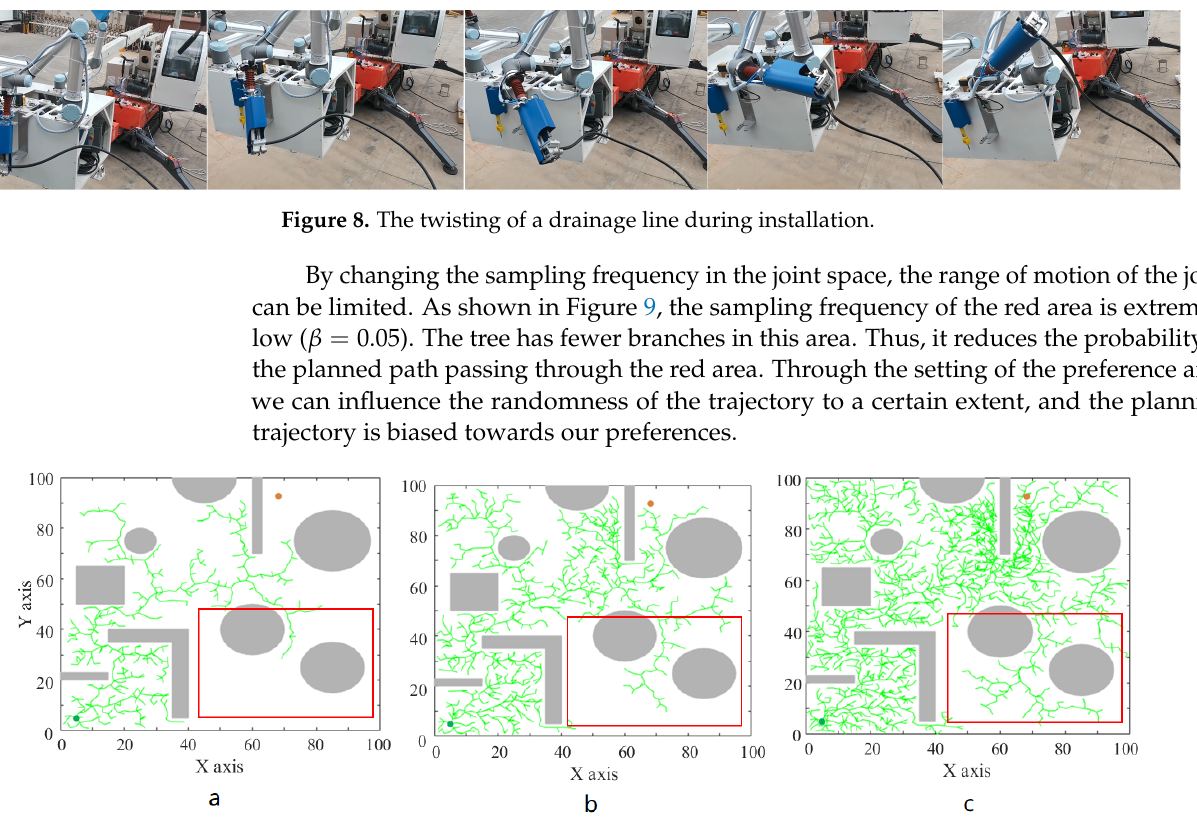
Figure 9. Tree expansion influenced by the change in regional sampling frequency (sampling times = 500/1000/2000, α = 0.5, and β =